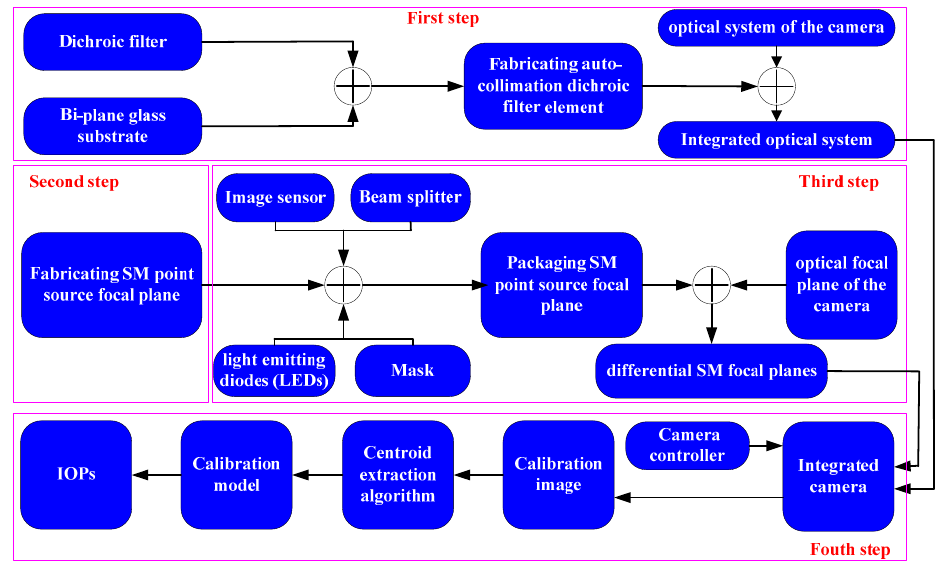
Figure 2. Logical chart of the proposed method.